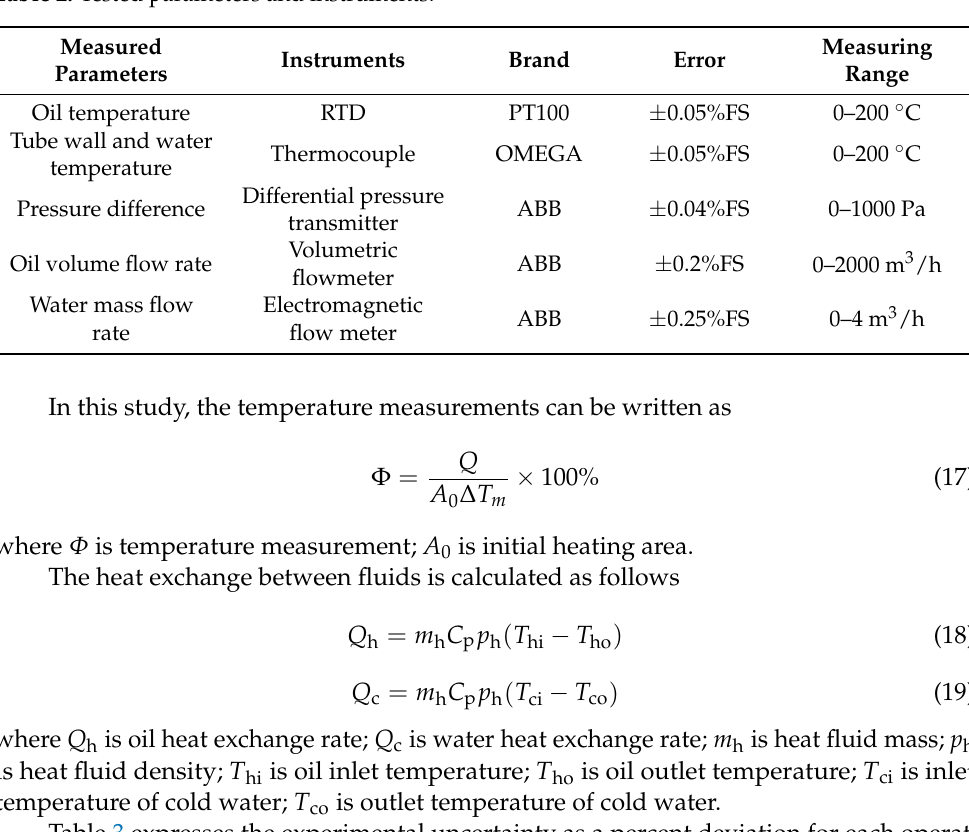
Table 2. Tested parameters and instruments.